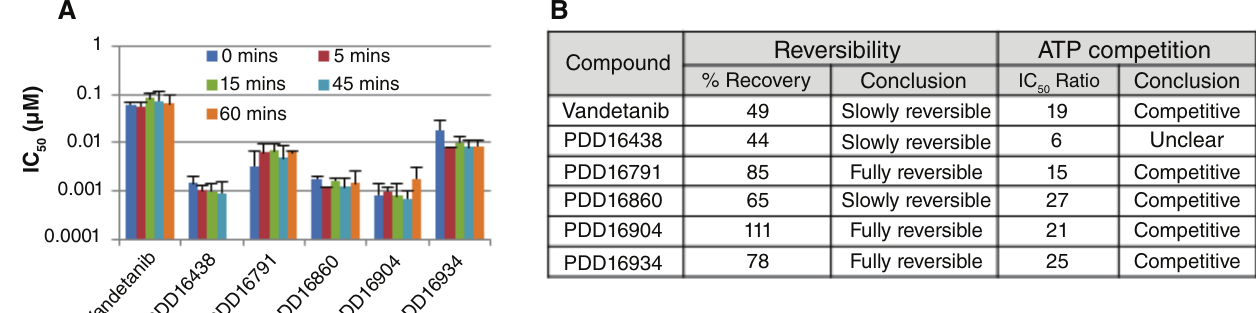
value. ( B ) Table showing 50